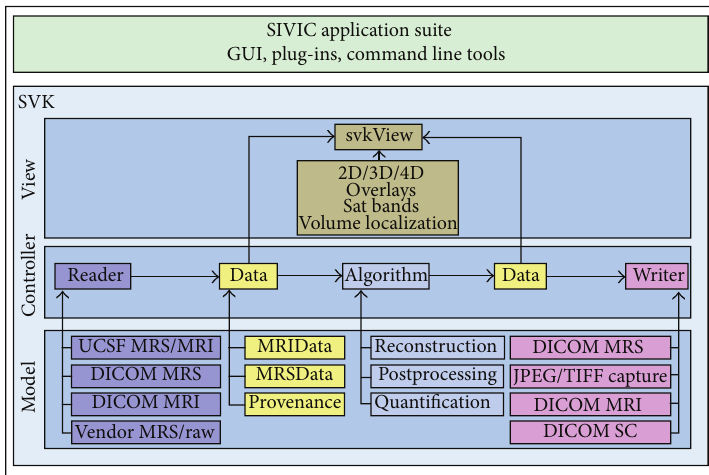
Figure 2: SIVIC software suite components. SIVIC applications (top) are built using the SIVIC Kit (svk) bottom. The svk is a C++ library representing a model, view, controller (MVC) design. View classes provide components that graphically display data and acquisition constructs represented by svkImageData objects (yellow). The controller layer utilizes svk IO (readers, writers) and svk algorithm classes to provide analysis functionality. The underlying svk model is represented by specific implementations of IO, algorithm, and data structure classes. Some specific examples of each class hierarchy are shown in the model (bottom